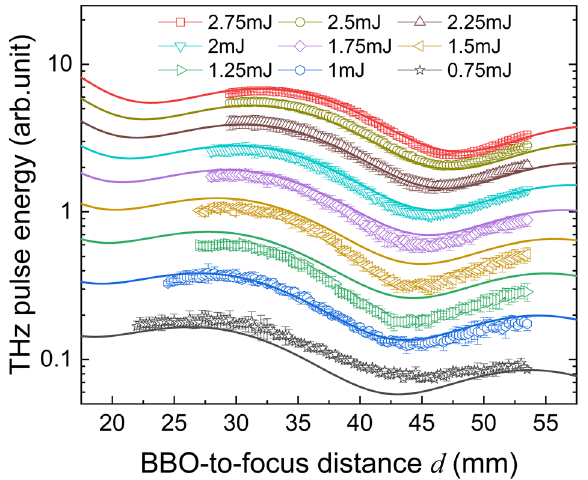
Figure 2. THz radiation evolution by changing the incident IR pulse energy and BBO-to-focal distance. Symbolic points are the THz pulse energy obtained at different type-I β-BaB 2 O 4 (BBO)-to-focal distance d and incident pulse energy I ω adjusted by an optical attenuator from 0.75 to 2.75 mJ; Solid curves are the fitting results according to an oscillatory power function Eq. (9) described in the “Results and discussion” section. Error bars represent the standard deviation of three